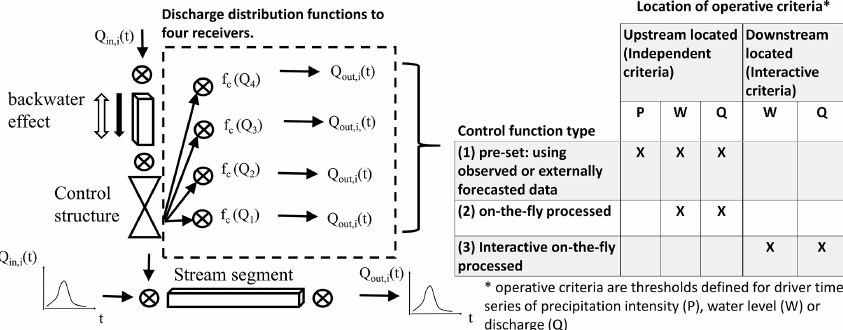
Figure 4. Scheme of a control structure with discharge distribution functions to four receivers and the three control function types depending on operative criteria.